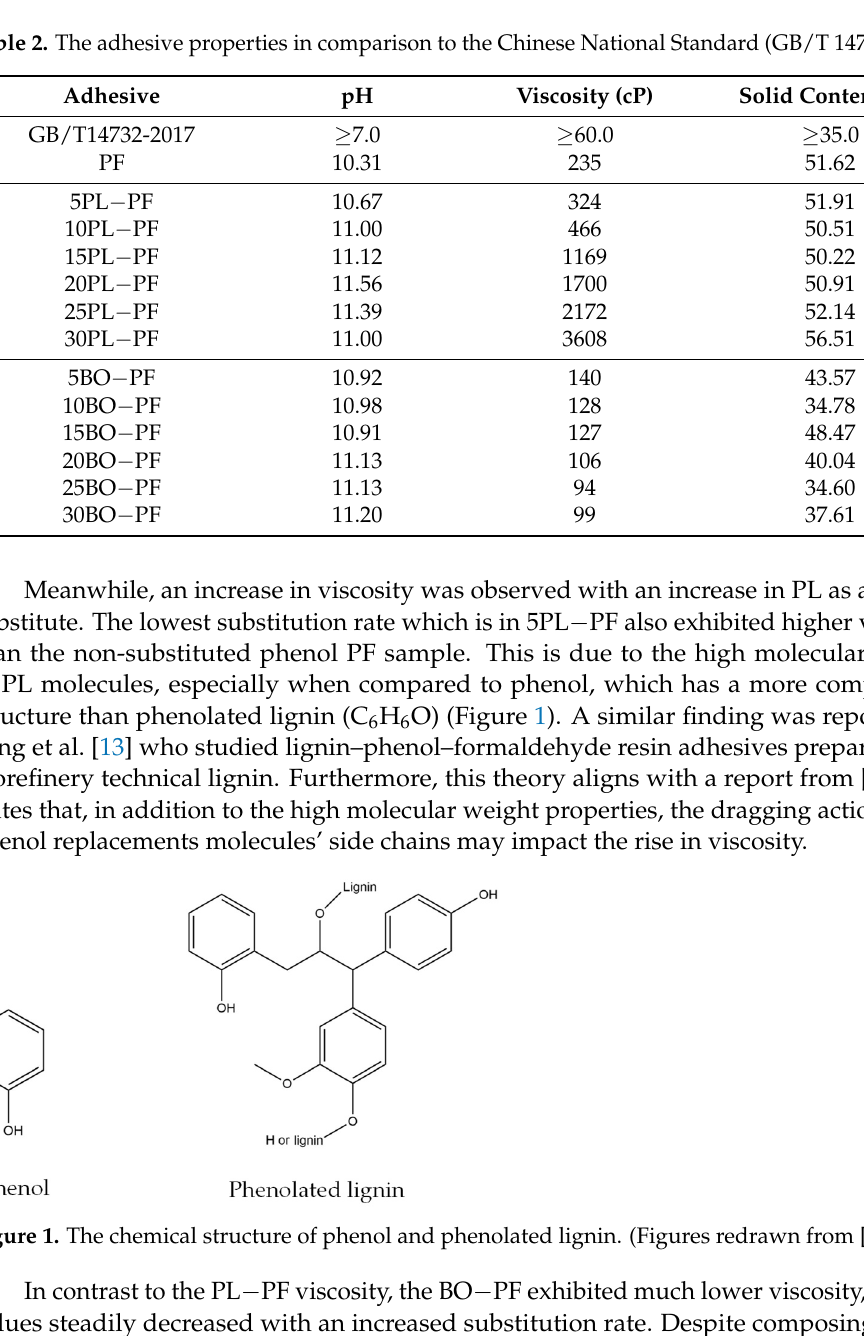
phenolics compounds with higher molecular weight than phenol and side chains such as 2,6-